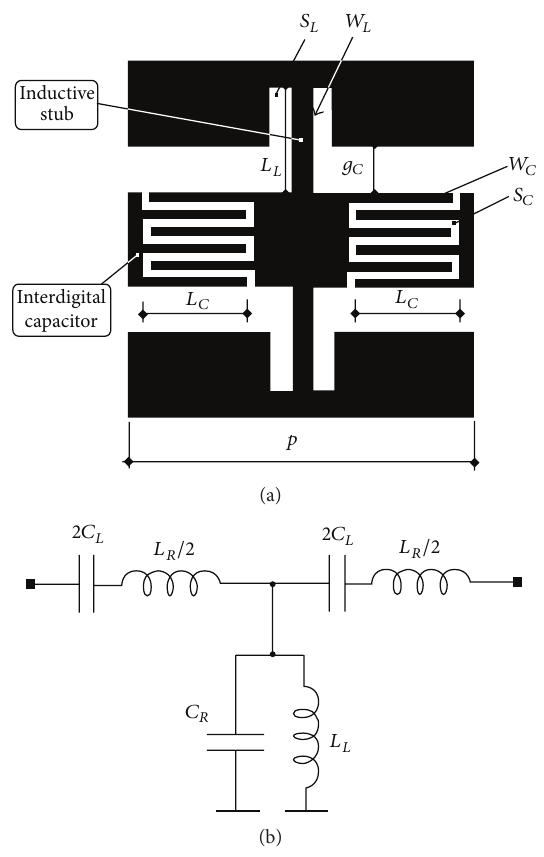
Figure 1: CPW CRLH elementary cell used in ZOR antenna construction: cell layout (a) and the equivalent circuit